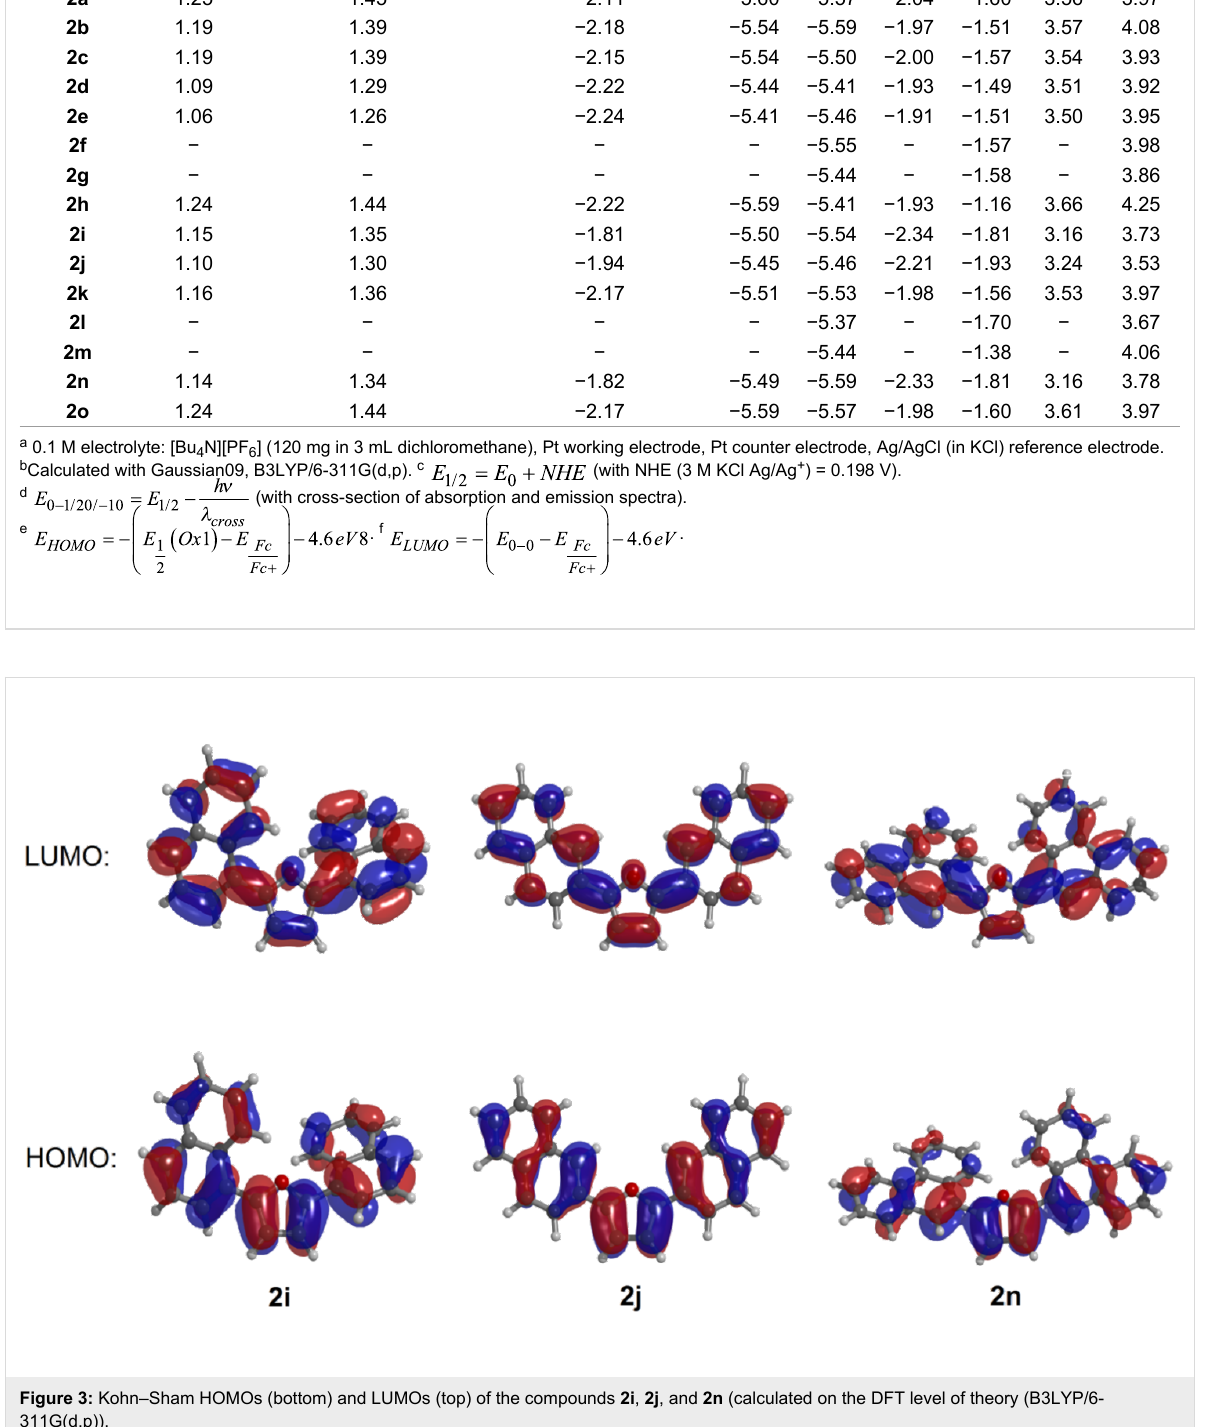
Compound E 00/+1 [V] c